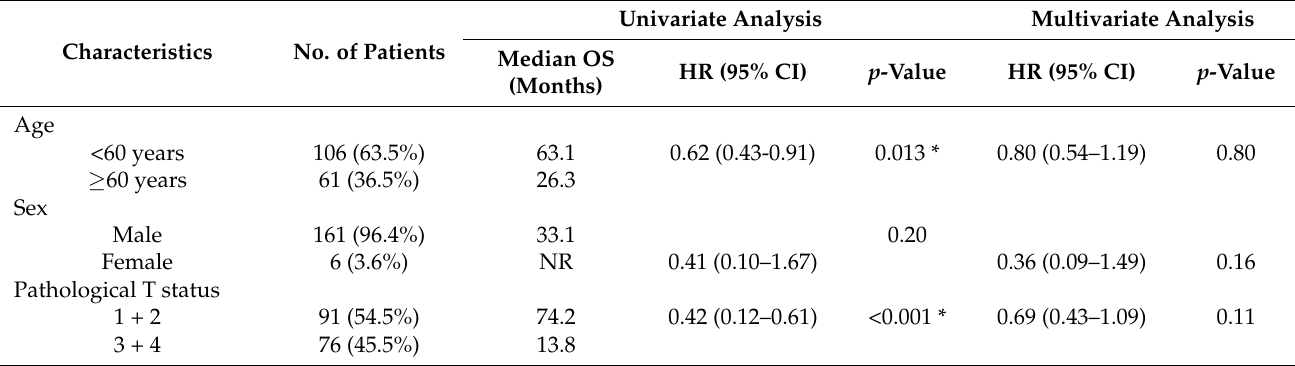
Table 3. Univariate and multivariate analysis of overall survival (OS) in 167 patients with esophageal squamous cell carcinoma receiving surgical